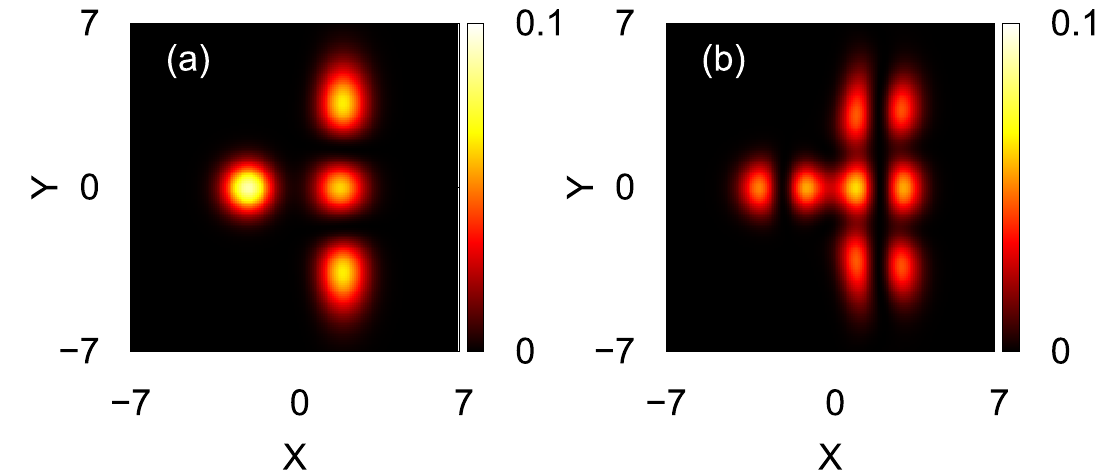
Figure 10. The densities per particle for the initial states ( a ) (cid:31) G and ( b ) (cid:31) X . The interaction parameter is t Rabi from the time-dependent solution of the Gross-Pitaeveskii 0.01 π . The plots are generated at t � = ≈ equation. We show here dimensionless